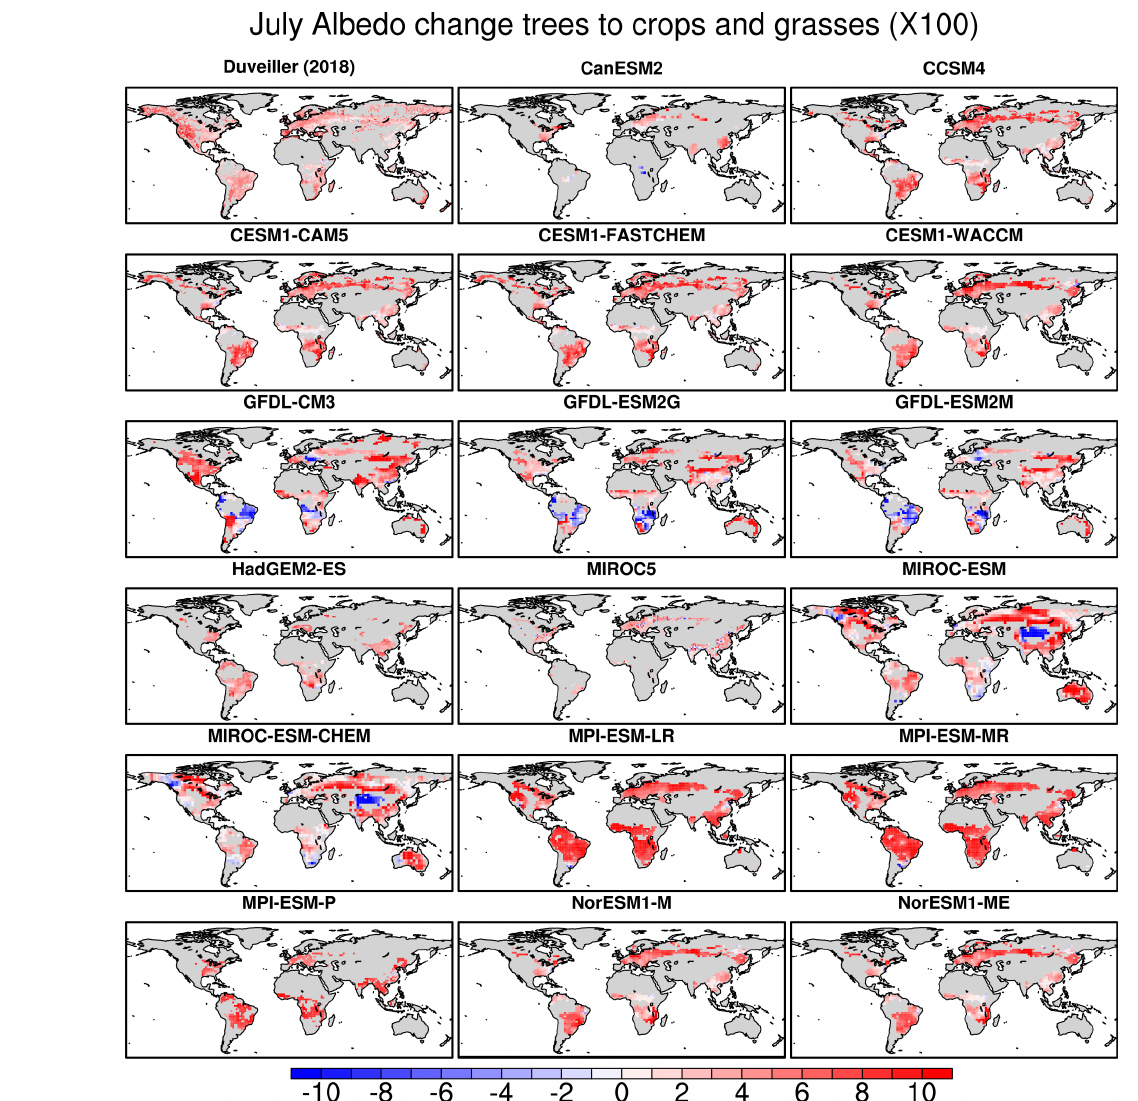
Figure 10. Potential present-day July albedo change associated with a transition from trees to crops–grasses according to the observational dataset of Duveiller et al. (2018a, derived from satellite data collected over the 2008–2012 period; top left corner) and in the analysed CMIP5 models (the climatology over the 2000–2004 period was reconstructed). Note that the absolute differences have been multiplied by 100 to facilitate